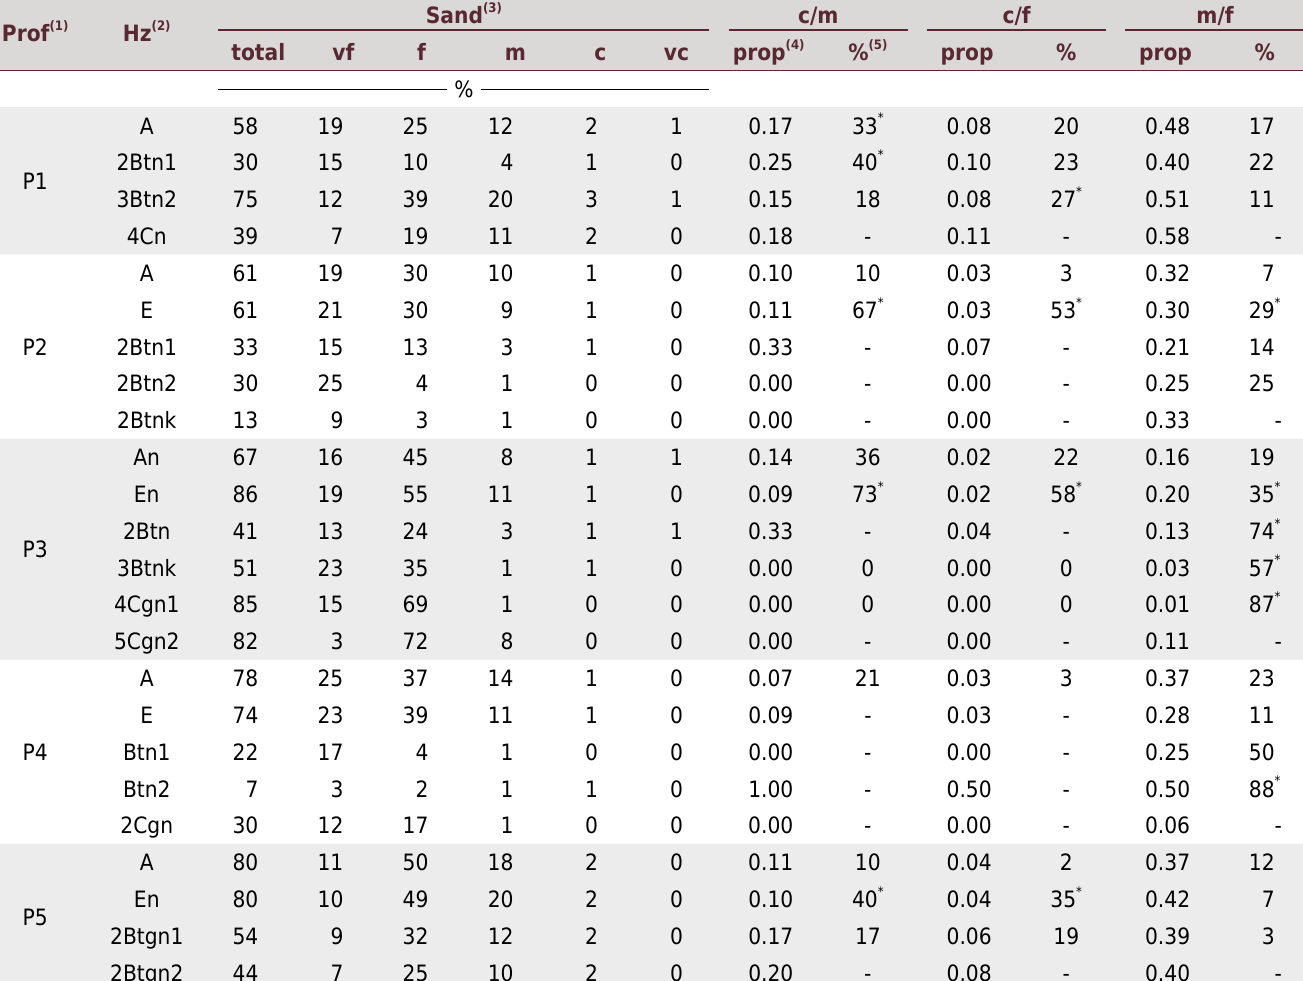
Table 4. Fractionation of the sand classes, sand contents ratios, and their variation in percentage to determine lithologic discontinuity Sand Prof (1) Hz (2)